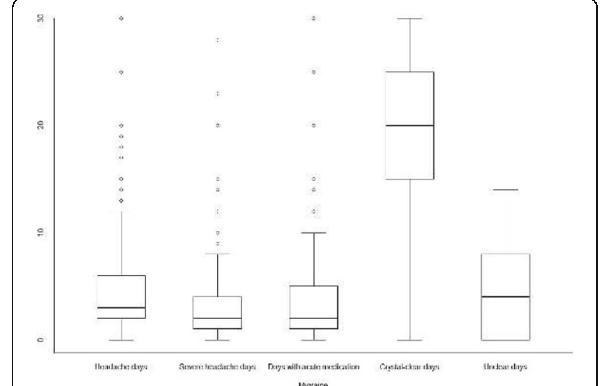
Fig. 1 (abstract P137). See text for description.